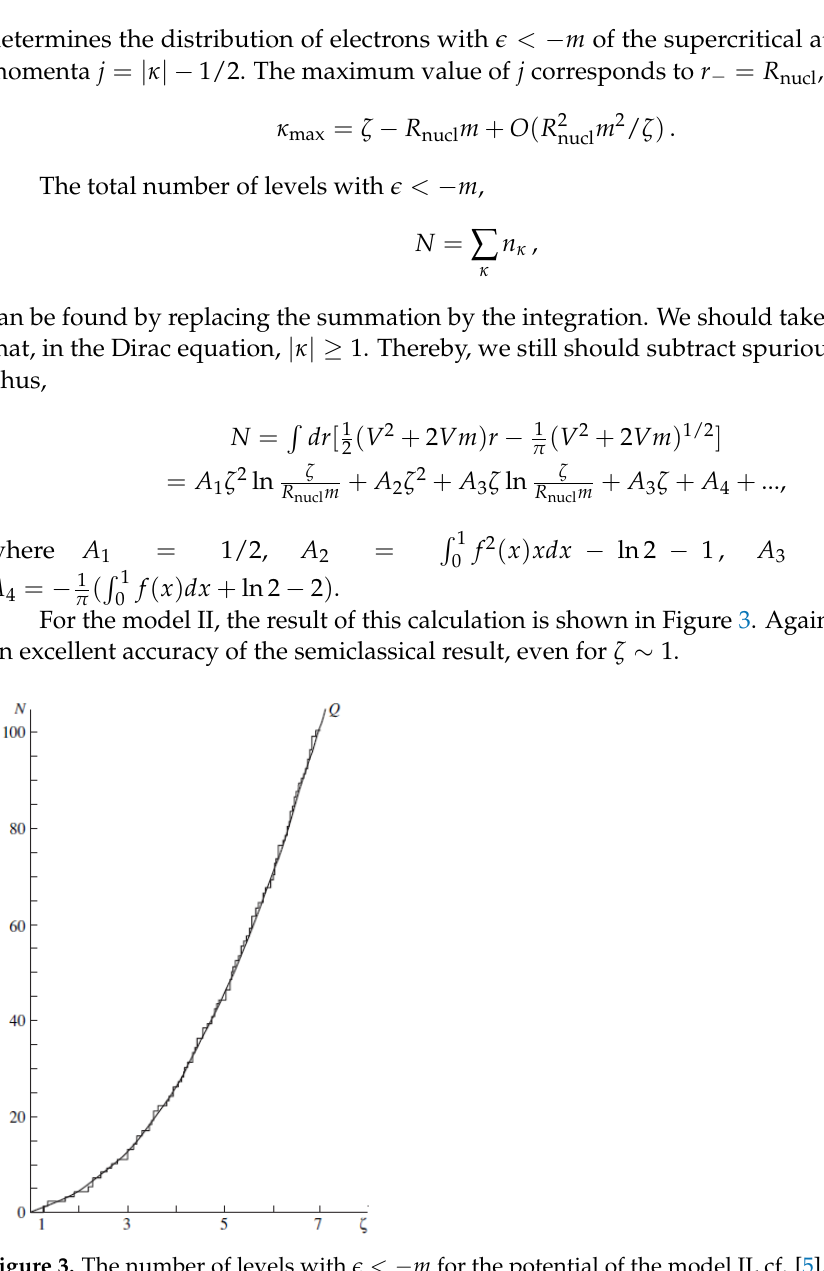
Figure 3. The number of levels with (cid:101) < − m for the potential of the model II, cf. [5]. The stepwise broken line represents a numerical solution of the Dirac equation, while the curve Q was computed according to the semiclassical Equation